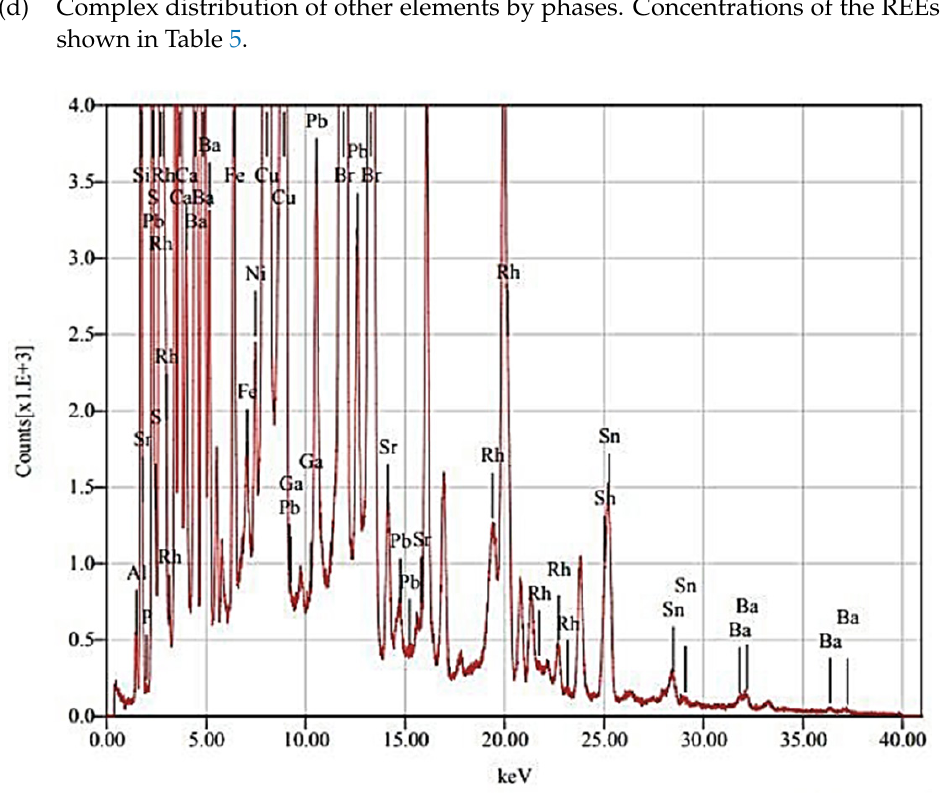
Table 4. Chemical composition of fractions C1, M1, and NC1.